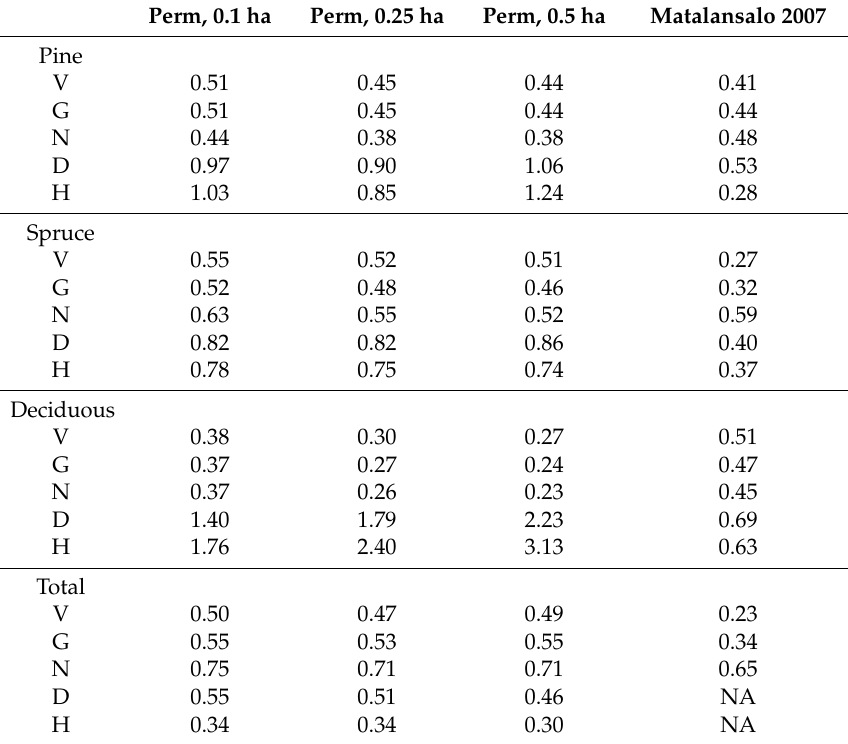
Table 6. Stand level RMSE values relative to the standard deviation in Perm and Matalansalo 2007. In Perm, the results are presented for three different levels of